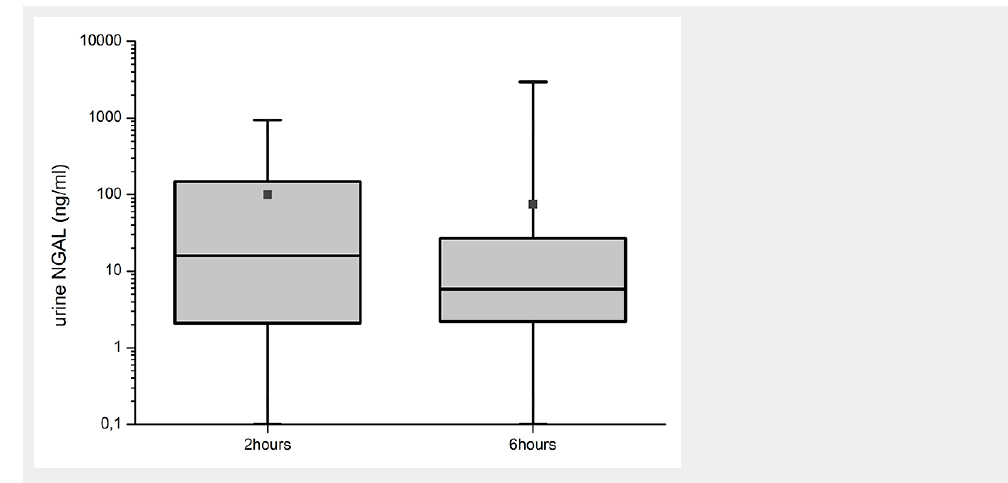
Figure 3 Box and whisker plot of urine neutrophil gelatinase-associated lipocalin (NGAL) values in all patients 2 hours and 6 hours after the end of cardiopulmonary bypass. Boxes: 25 th percentile (bottom line), median (middle line), and 75 th percentile (top line); bars: range; squares: means. Note the logarithmic scale.